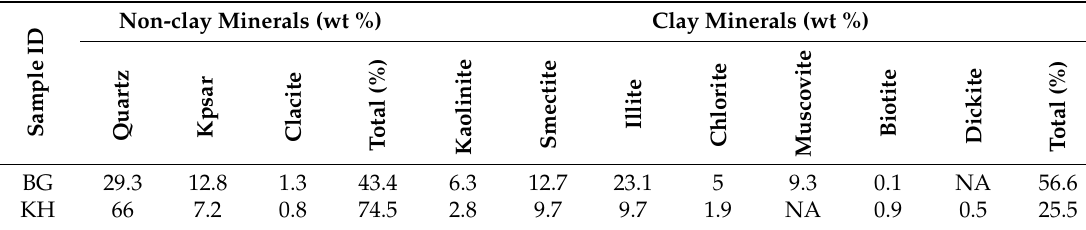
Table 2. Quantitative XRD results.